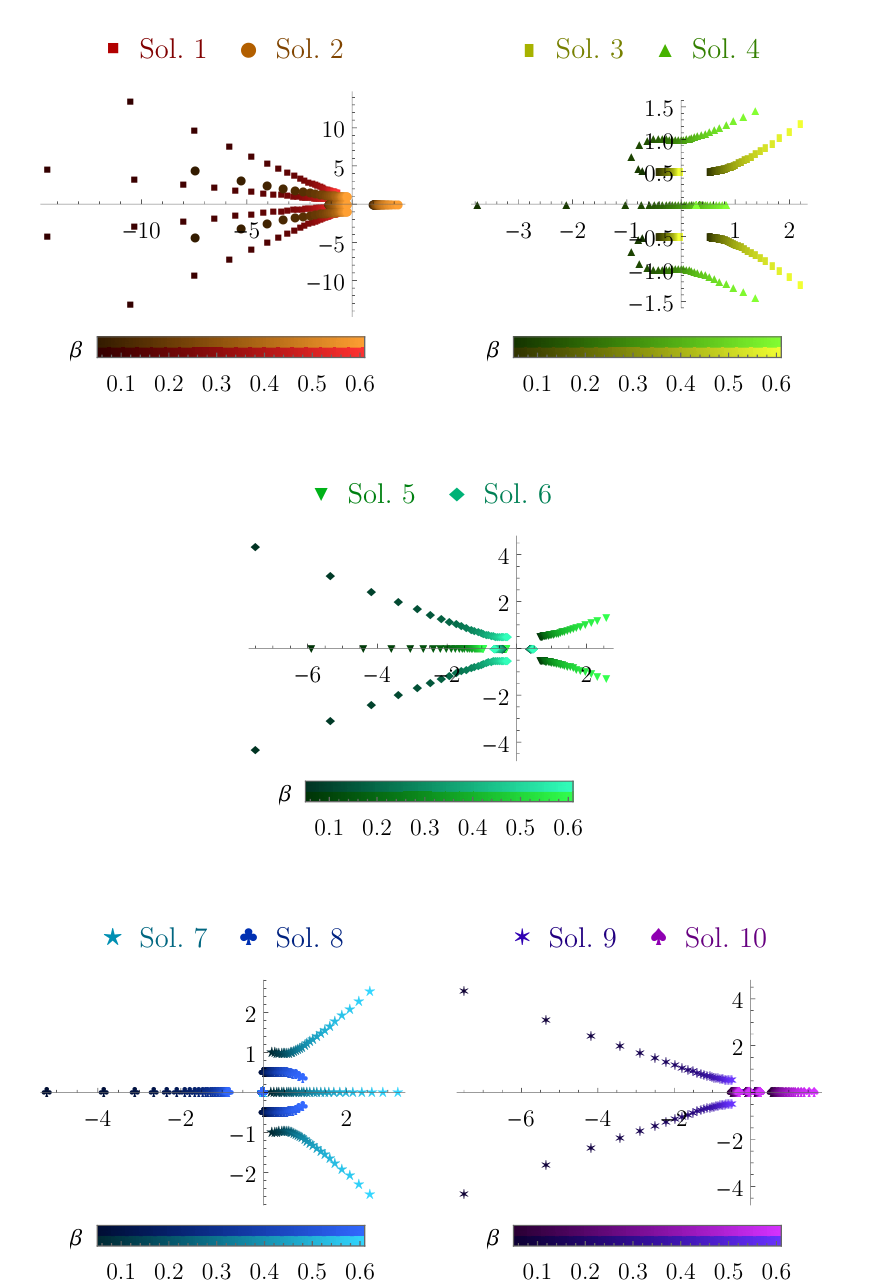
Figure 2 . Plots in the complex plane of the Bethe roots u i corresponding to the ten translationally invariant states with L = 8 and M = 4 at various values of the twist (cid:12) . The gradients from dark to brighter colors indicate which four Bethe roots that constitute the solution at the corresponding (cid:12) -value in the range 0.05{0.61.